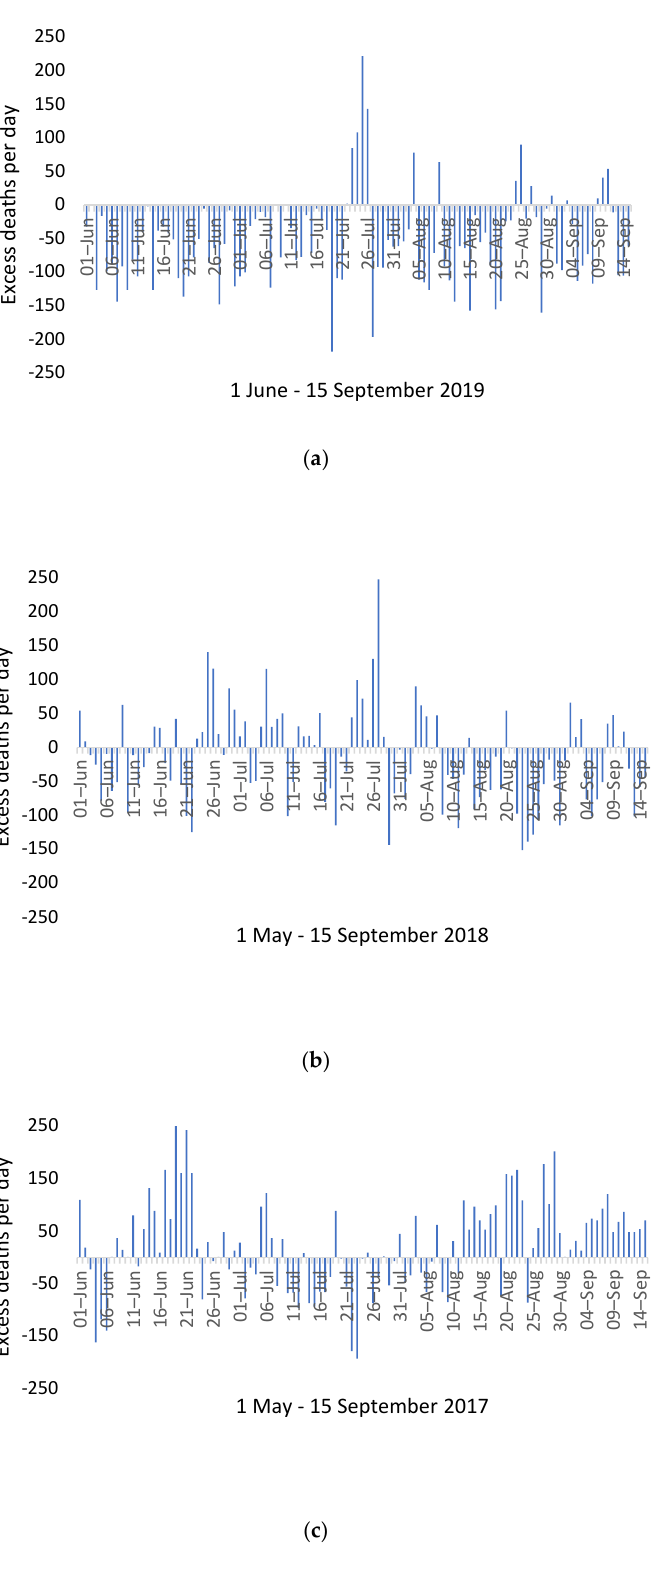
Figure 3. Daily excess deaths during the summer period (1 June to 15 September) for ( a ) 2017, ( b ) 2018 and ( c ) 2019 based on daily death occurrences. The negative excess deaths refer to days when death was lower than expected relative to the average of the previous 5-year